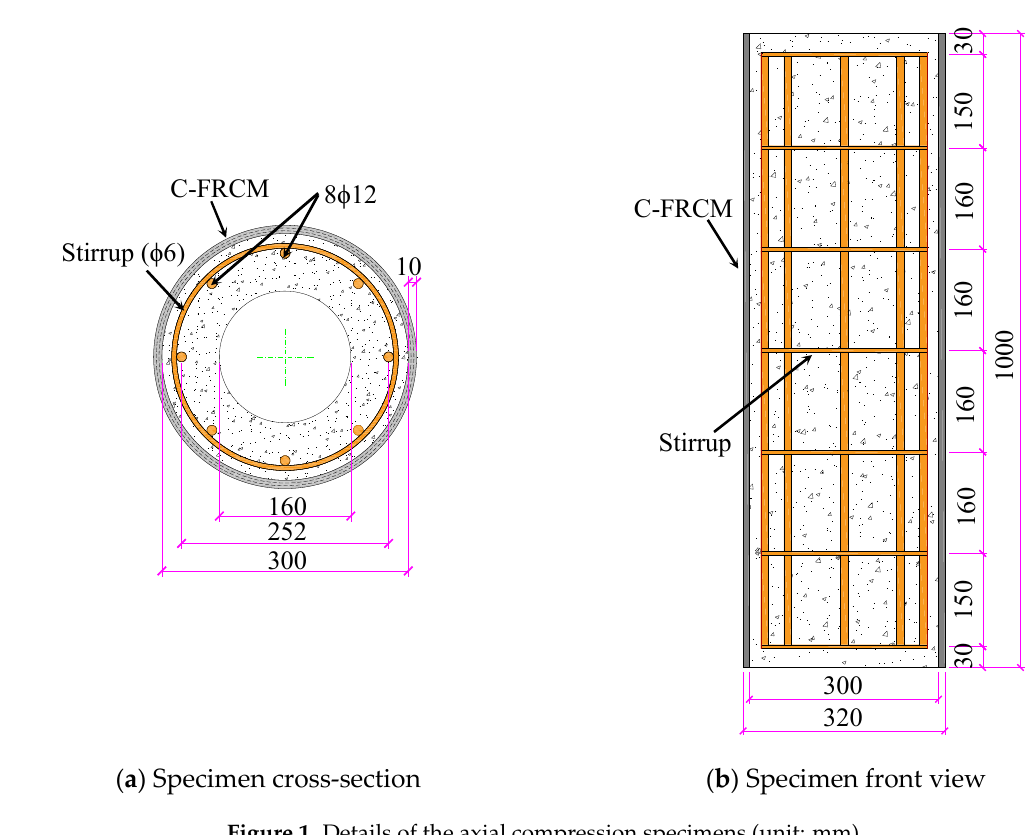
Figure 1. Details of the axial compression specimens (unit: mm).